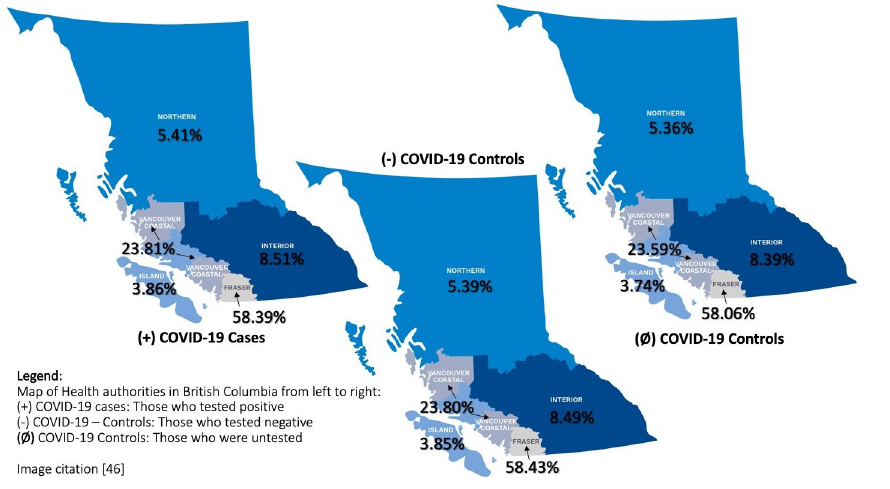
Fig 3. Geographic distribution of COVID-19 cases and controls. Image citation [46].